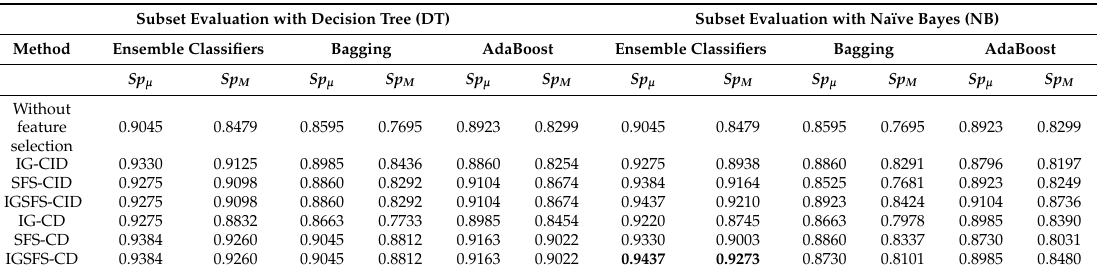
Table 9. Specificity comparison using micro-averaging and macro-averaging methods with ensemble learning methods for